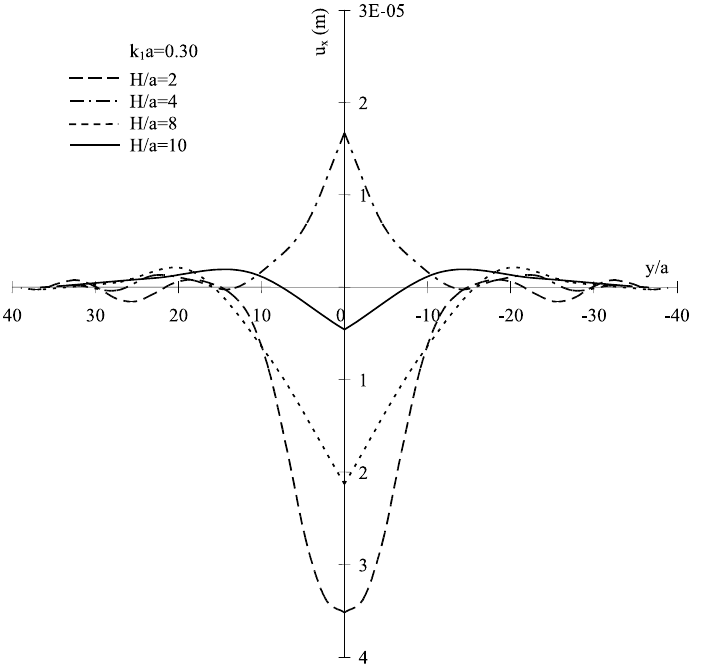
Fig. 9. Variation of the vertical displacement ( u x ) with y/a at the free surface of the half-space for various values of depth H/a